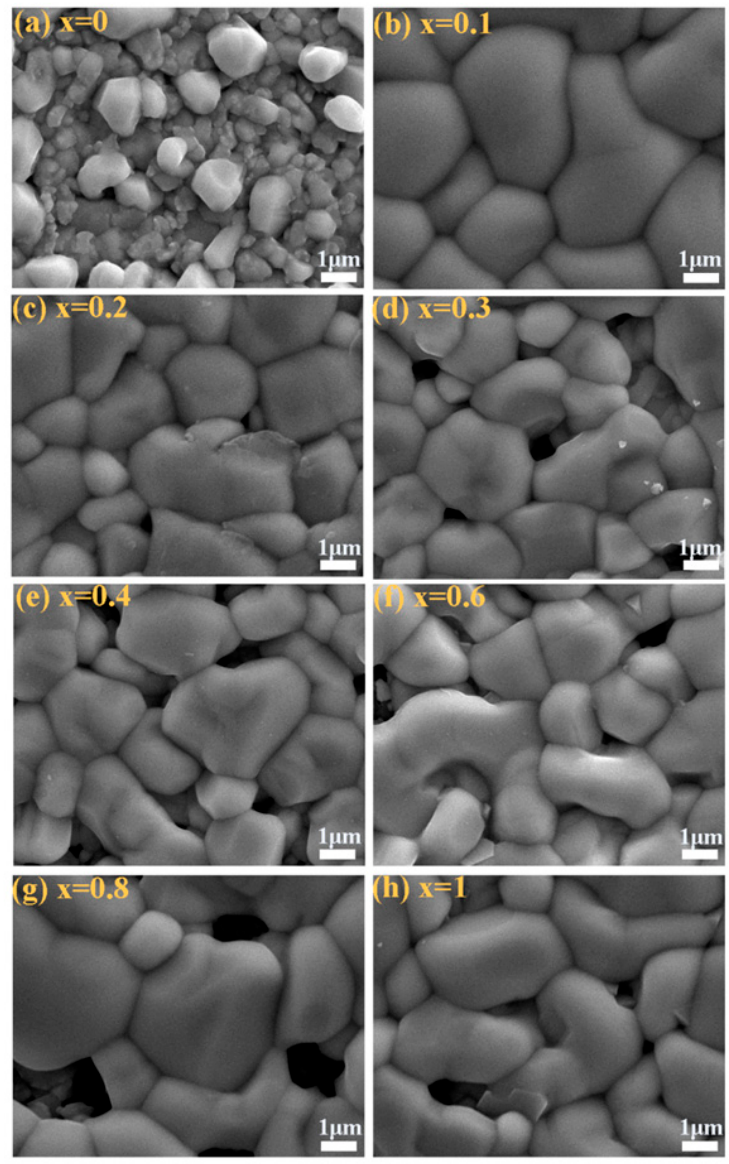
Figure 5. SEM images of the Cu 2 Mn x Zn 1 − x Sn(S,Se) 4 (0 ≤ x ≤ 1) alloy thin films: ( a ) x = 0, ( b ) x = 0.1, ( c ) x = 0.2, ( d ) x = 0.3, ( e ) x = 0.4, ( f ) x = 0.6, ( g ) x = 0.8, ( h ) x = 1.